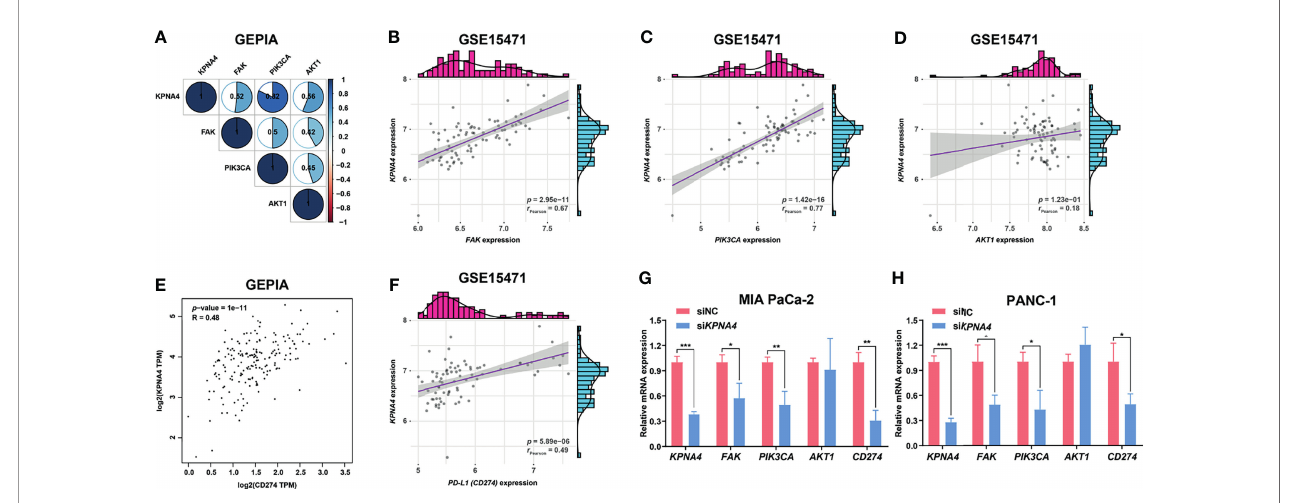
FIGURE 7 | KPNA4 is positively related to FAK signaling and PD-L1 expression. Correlation analysis among the expression of KPNA4 , FAK , PIK3CA and AKT1 in TCGA PDAC (A) . In GSE15471, KPNA4 expression was signi fi cantly correlated with FAK (B) and PIK3CA (C) , while no obvious association was observed between KPNA4 and AKT1 (D) . There was signi fi cant relationship between KPNA4 expression and PD-L1 (CD274) in TCGA PDAC (E) and GSE15471 (F) . The regulatory effect of KPNA4 knockdown on FAK , PIK3CA , AKT1 and CD274 expression in MIA PaCa-2 (G) and PANC-1 cells (H) by qRT-PCR analysis. * p < 0.05, ** p < 0.01, *** p <